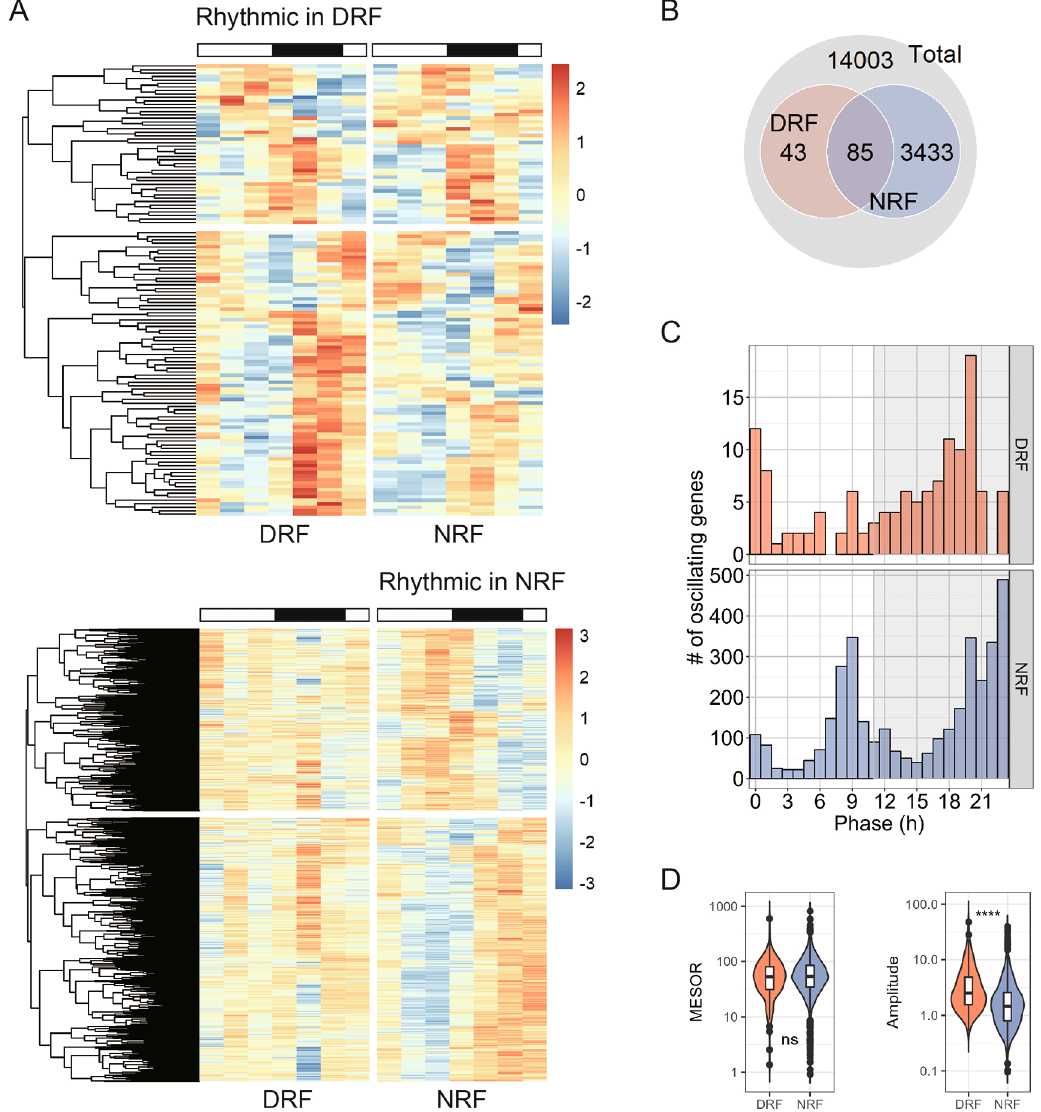
Figure 1. Global transcript profiling of anterior hypothalamus from time-restricted fed female mice. (A) Heatmap showing 24-h expression profiles of rhythmic transcripts in the anterior hypothalamus. Samples were dissected from time-restricted fed nine-week female mice every four hours for a complete daily cycle (n = 4 mice per time point). (B) Interaction of rhythmic transcripts between day time-restricted feeding (DRF) and night time-restricted feeding (NRF). (C) Distribution of the phase. (D) Midline estimating statistic of rhythm (MESOR) and amplitude of rhythmic transcripts. Data are presented as boxplots. Mann-Whitney test; ns, not significant, ****p <